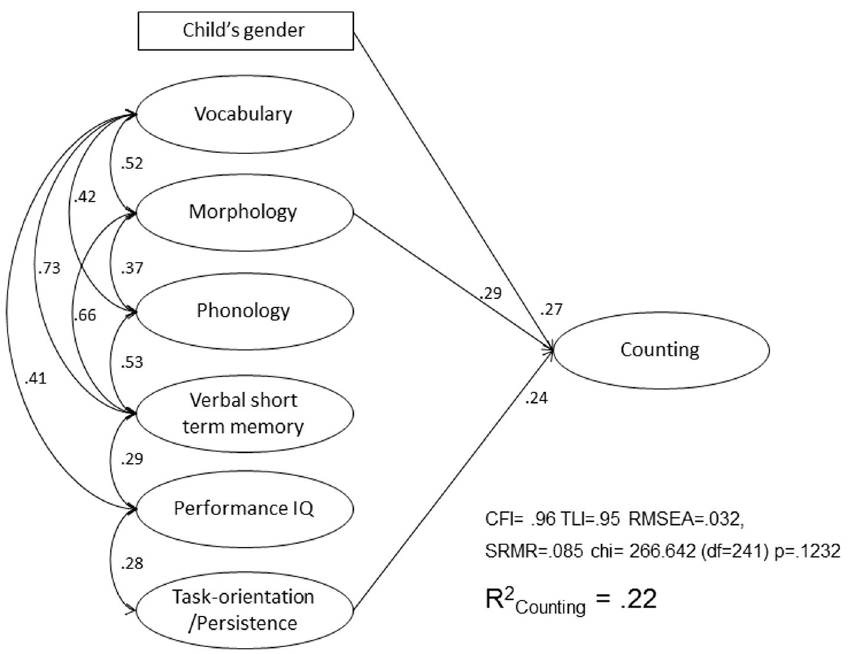
Figure 3. The final model, including language-related predictors, child’s persistence, and gender. All significant paths